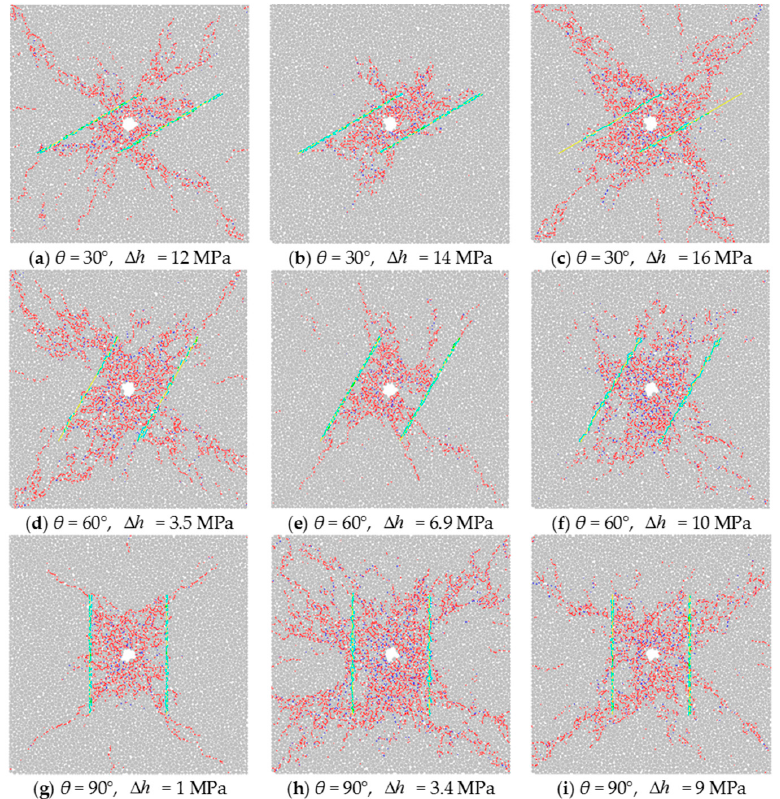
h Δ h Δ . . Figure 14. Numerical results of HF and NF interactions at different values of θ and ∆ h